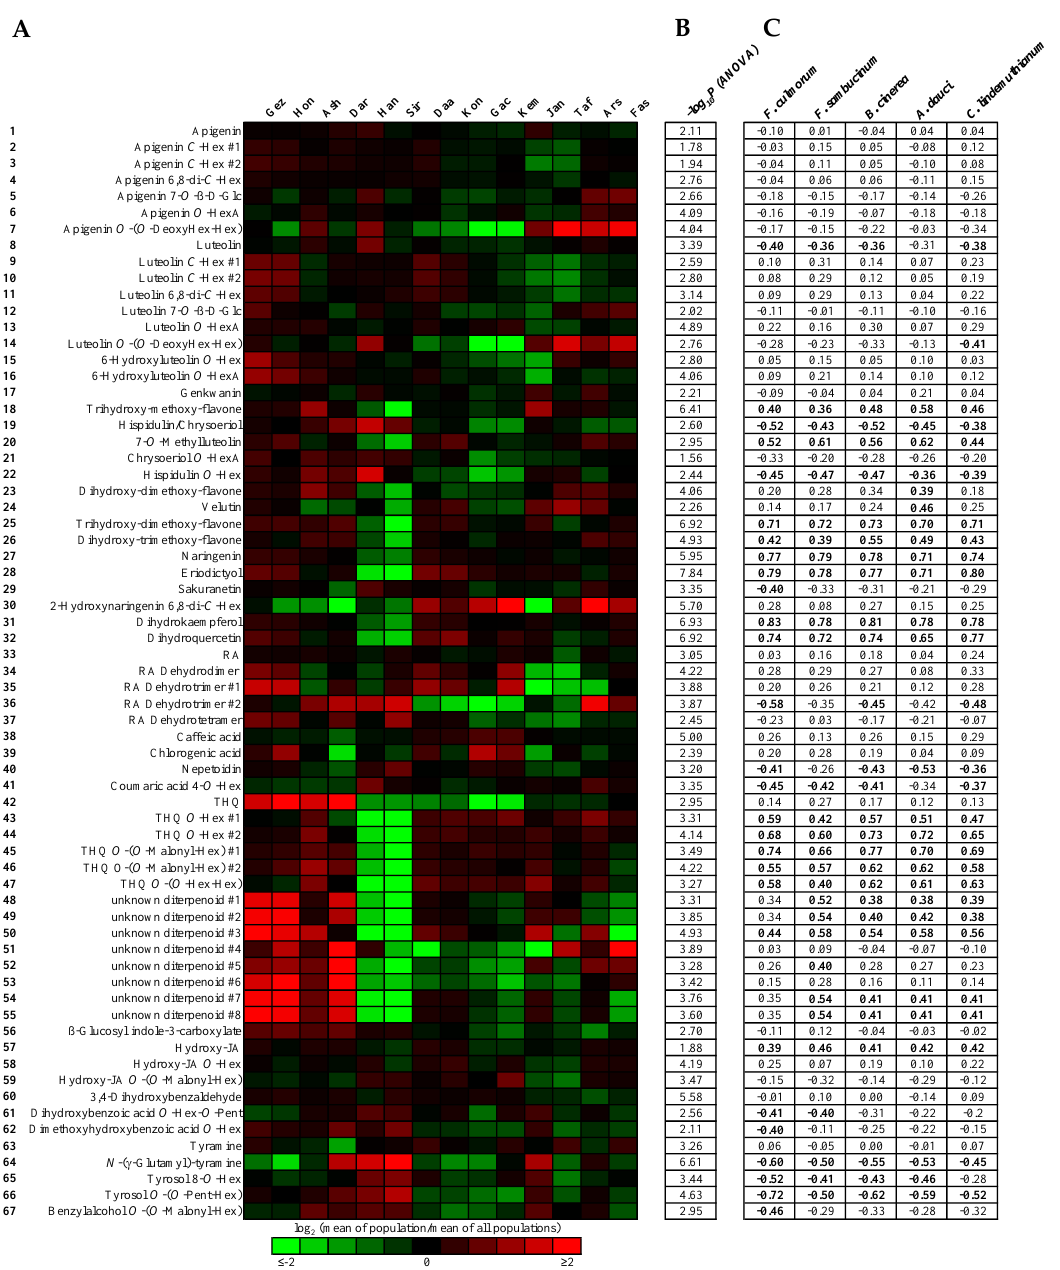
Figure 3. Heatmap representation of mean abundances of metabolites 1–67 in leaves of 14 Z. multiflora populations ( A ). Adjusted p values from variance analyses of metabolite abundances with population as factor ( B ). Spearman’s rank correlation coefficients calculated from metabolite abundances and fungal inhibition rates (n = 42). Statistically significant rank correlations ( p adj ≤ 0.05) are marked in bold ( C ).